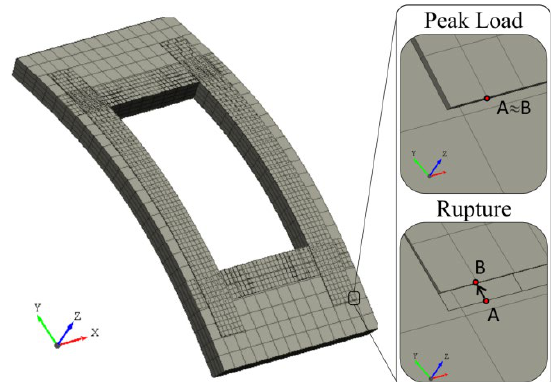
Figure 16. Relative displacement between the concrete and CFRP using 3D shell